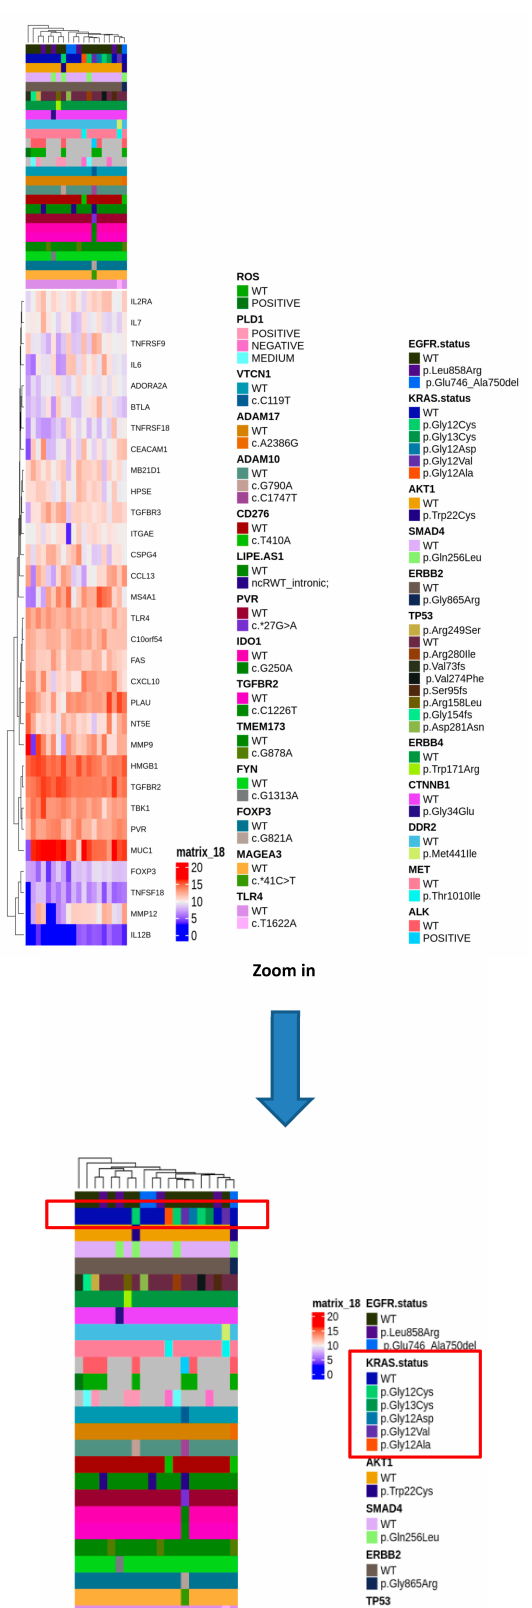
Figure 3. Complex heatmap annotated with all the genetic alterations detected in the real-life